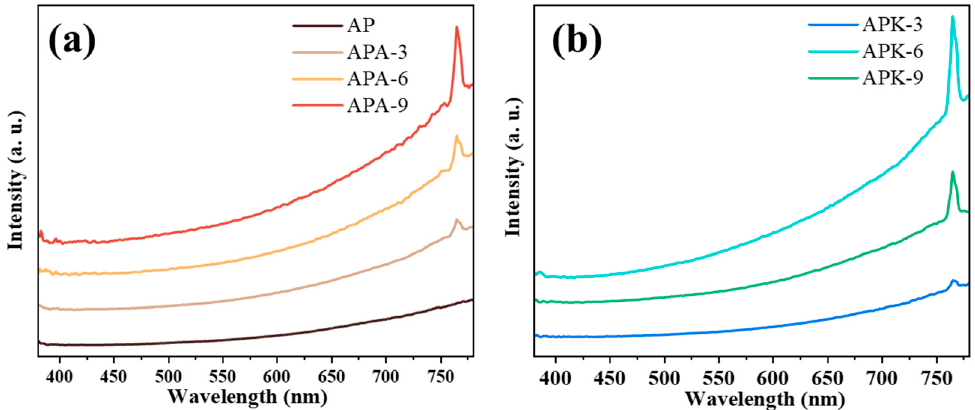
Figure 5. Typical combustion spectra of the samples: ( a ) AP, APA ‐ 3, APA ‐ 6, APA ‐ 9; ( b ) APK ‐ 3, APA ‐ 6, APA ‐ 9.